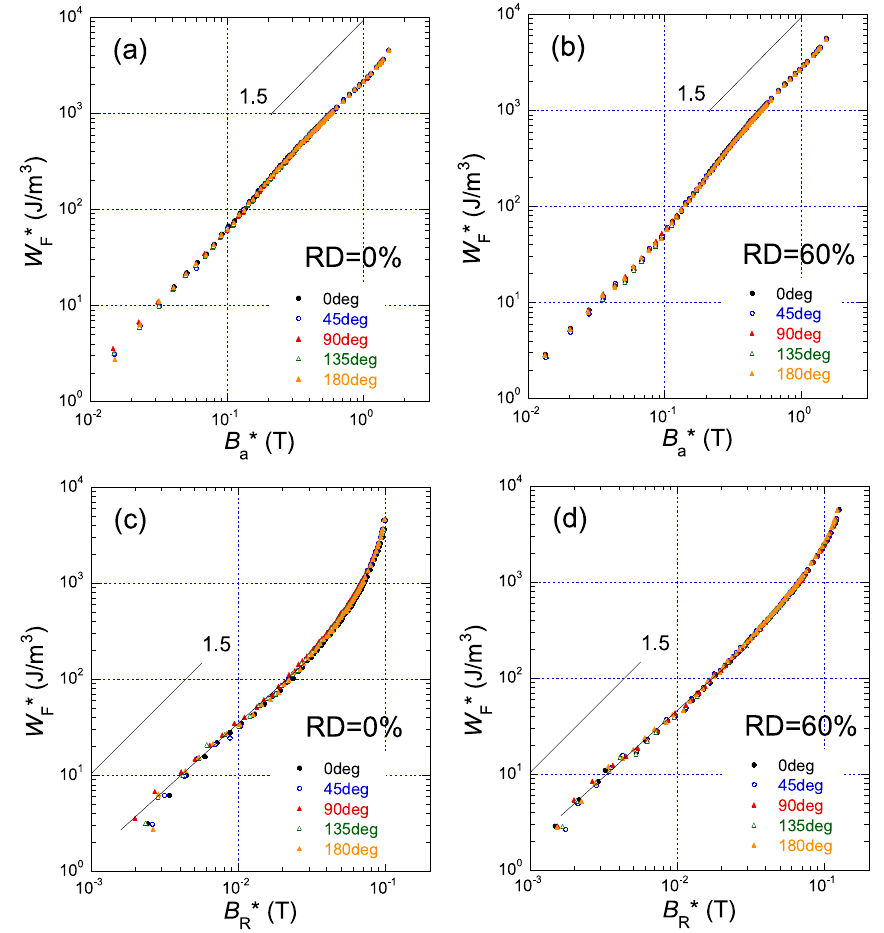
Figure 9. Double logarithmic plots of the relationship between W F * and B a * at ( a ) RD = 0% and ( b ) RD = 60%, and the relationship between W F * and B R * at ( c ) RD = 0% and ( d ) RD = 60%. For each plot, relations obtained with different values of θ are given.